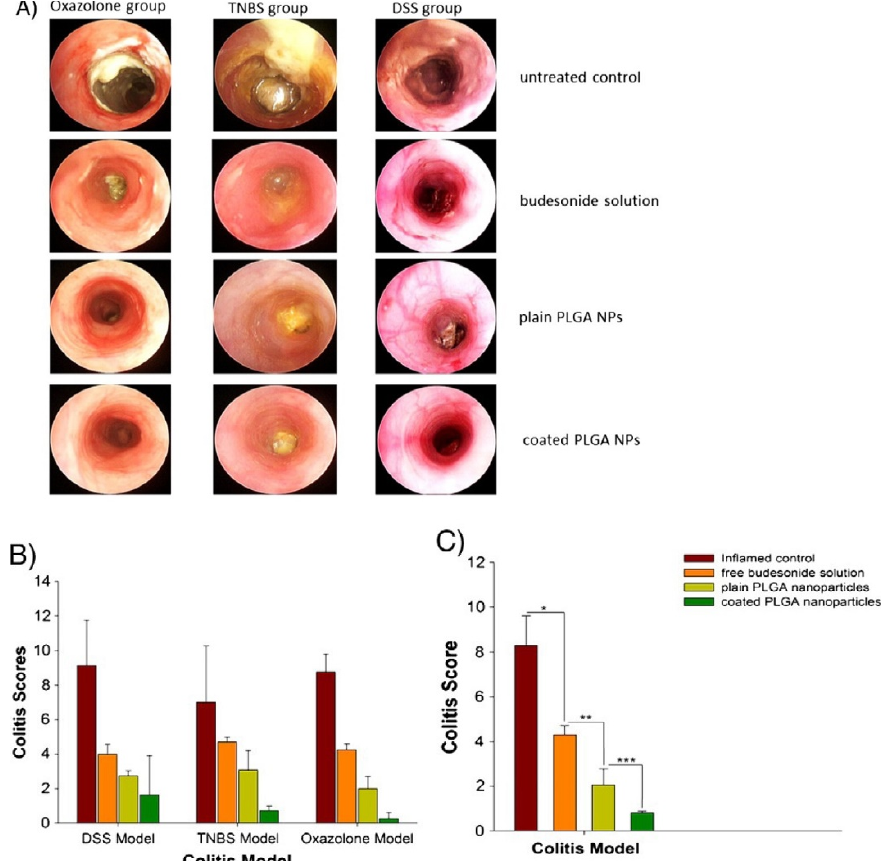
Figure 2. ( A ) In vivo high resolution mini-endoscopy of mice intestine after treatment. ( B ) Colitis score of all the three different animal models after treatment with free budesonide and budesonide- loaded nanoparticles in comparison with the inflamed group. ( C ) Pooled data of all untreated and treated groups for statistical significance Reprinted with permission from [16].